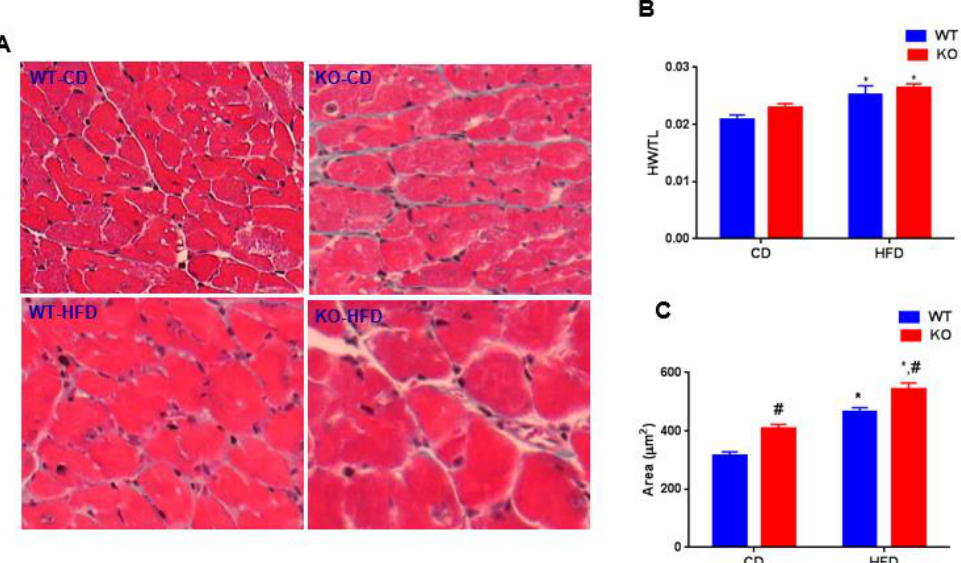
Figure 3. HFD-induced cardiac remodeling in WT and CM-GSK-3 β –KOs. ( A ) HF feeding increased cardiac hypertrophy in WT and KO as seen with increased heart weight (HW) / tibia length (TL) ( n = 7–11 per group). ( B ) Representative Masson trichrome-stained sections of whole heart isolated from WT and CM-GSK-3 β KO animals at 55 weeks post CD or HFD. ( C ) Quantification of CM cross-sectional area at 55 weeks post CD or HFD from WT and KO animals ( n = 6–8 per group). * p < 0.05 CD vs. HFD; # p < 0.05 WT vs. KO.